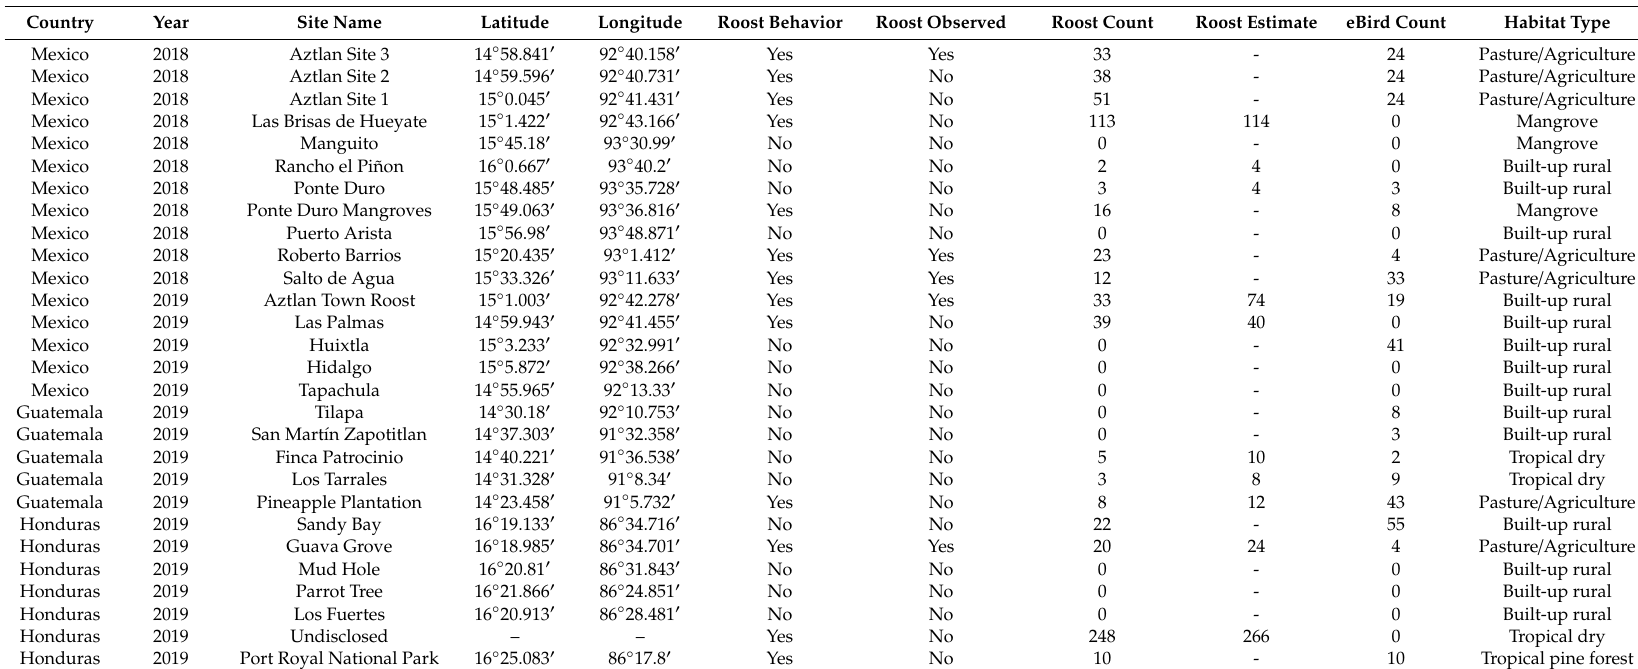
Table 1. A list of data collected from Mexico, Guatemala, and Honduras during 2018 and